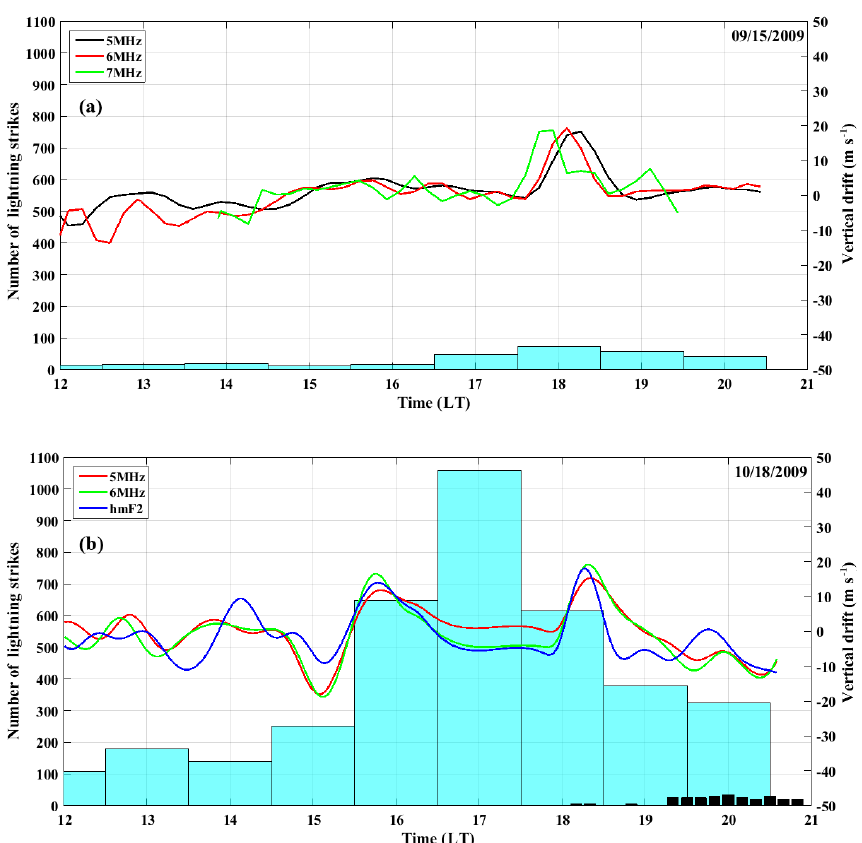
Figure 4. Vertical drift (colored lines), lightning strike activity (cyan bars) and the range of spread F, Q f (black bars), for 15 Septem- ber 2009 (a) and 18 October 2009 (b)